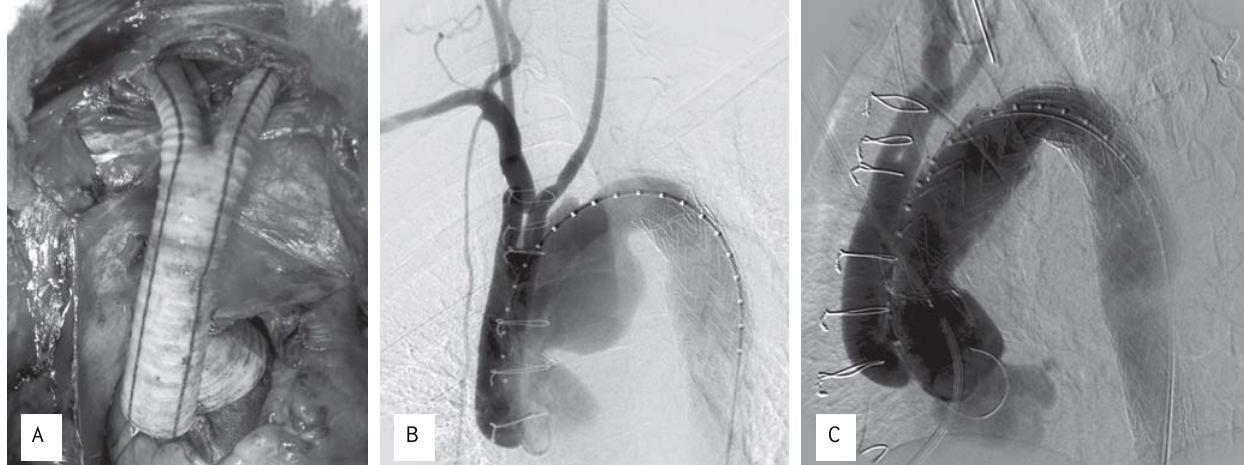
Fig. 2 – A: Paciente nº 5, portador de aneurisma de arco aórtico, tendo sido submetido há 4 anos a correção endovascular de aneurisma de aorta descendente. A: aspecto intra-operatório da correção do segmento proximal da aorta ascendente e da prótese bifurcada de dacron. O fio de marcapasso serve como orientação do posicionamento da endoprótese. B: Aortografia pré-implante da endoprótese, mostrando perviedade da reconstrução vascular. C: Aspecto final após implante de endoprótese